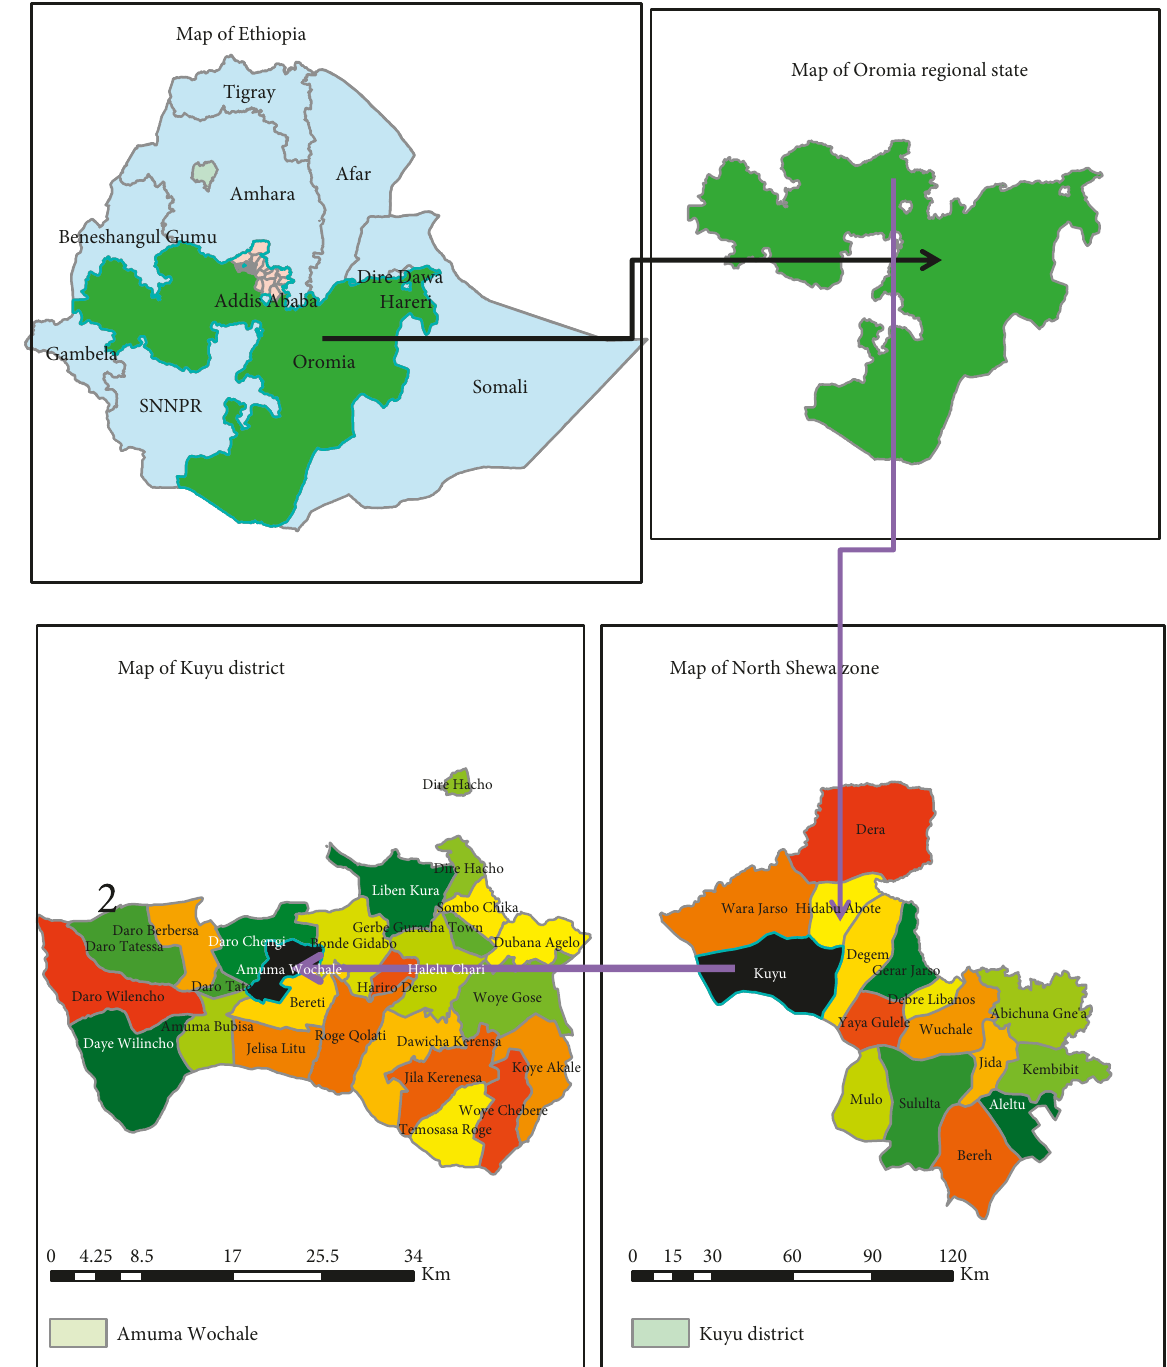
Figure 1: Map of Amuma Wuchale Kebele, Kuyu District, North Shewa Zone, Oromia Region,